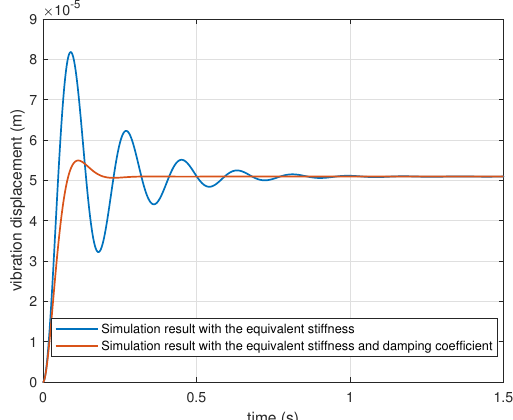
Figure 4. The simulation result with the equivalent stiffness and damping